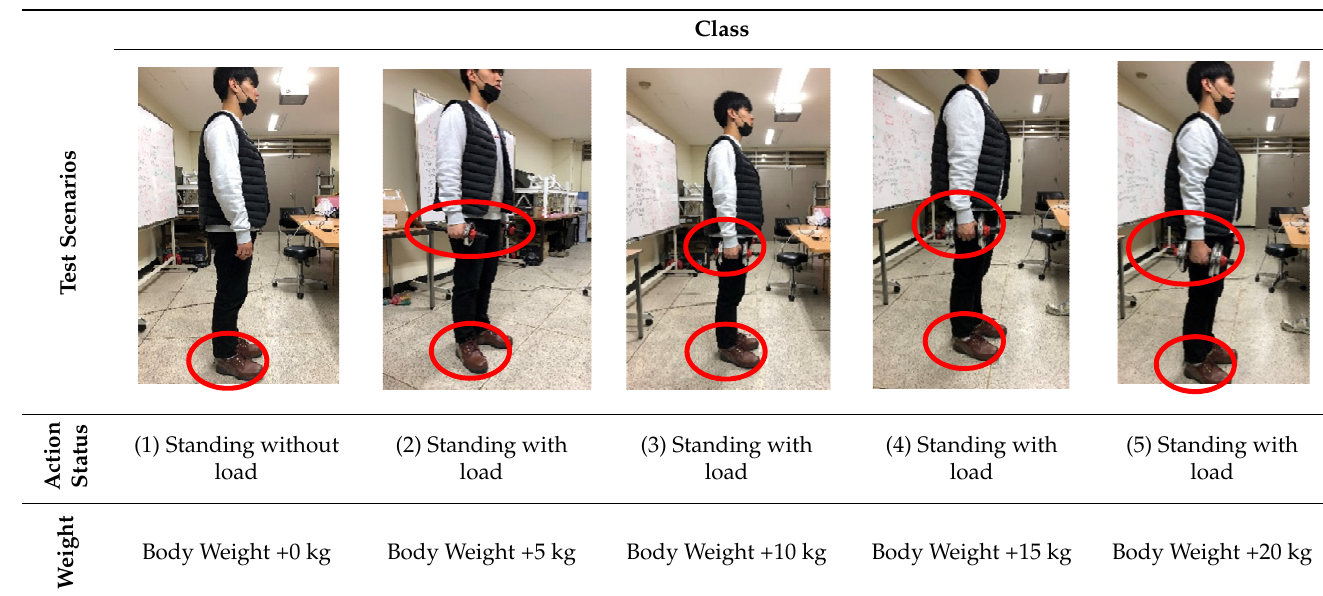
Table 2. The basic information of experimenter and the number of collected data sets.